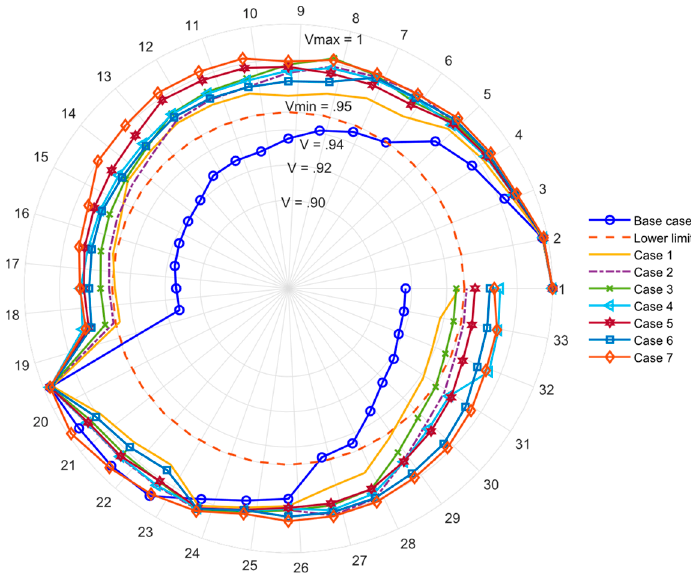
Figure 7. Voltage magnitude profile of the 33-node test DS for all cases. Table 1. Numerical results for IEEE 33-Node with and without SOP installation.